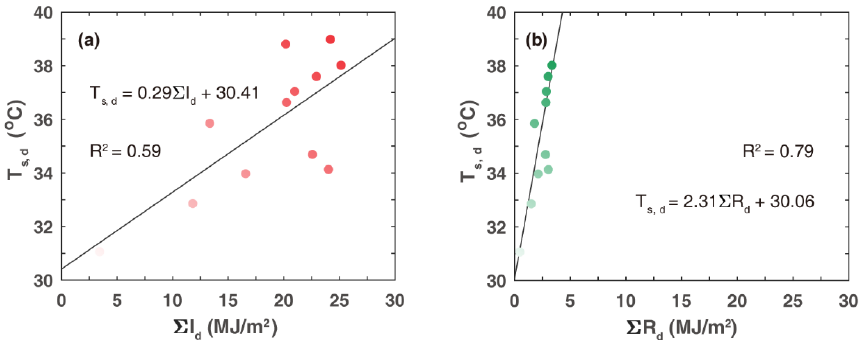
Figure 7. The daily surface temperature (T s, d ) of the grassland corrected with ( a ) Σ I d and with ( b ) Σ R d .